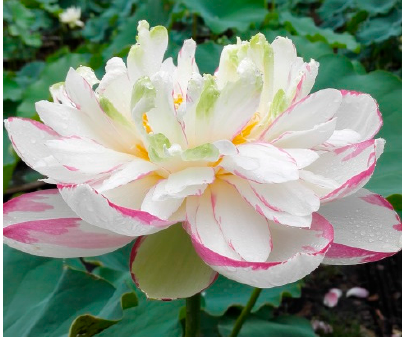
Figure 3. Lotus cultivar with spotted color flower.